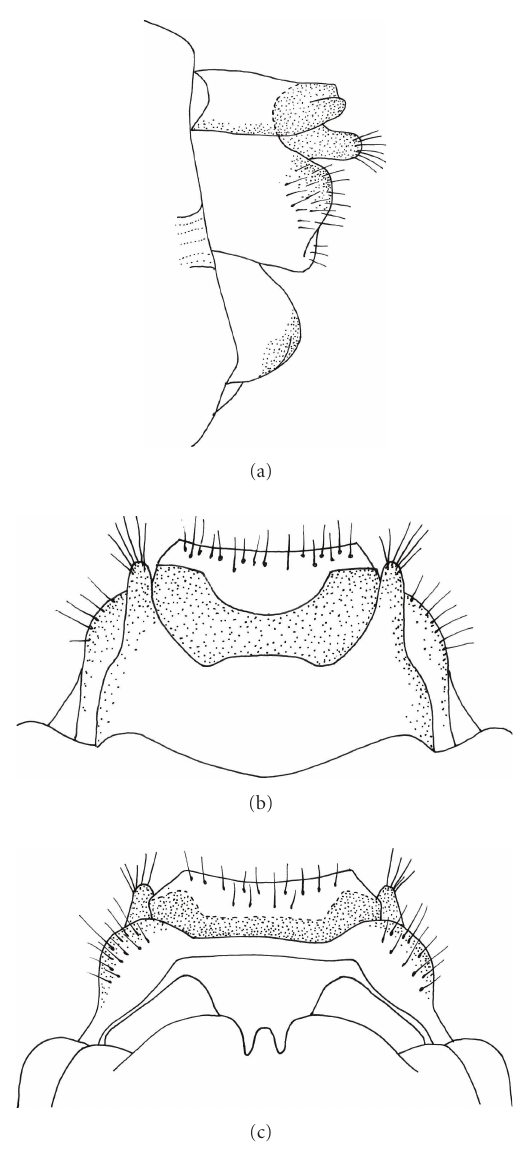
Figure 2: Chaetopteryx akgolensis sp.n., female genitalia: (a) lateral; (b) dorsal; (c)